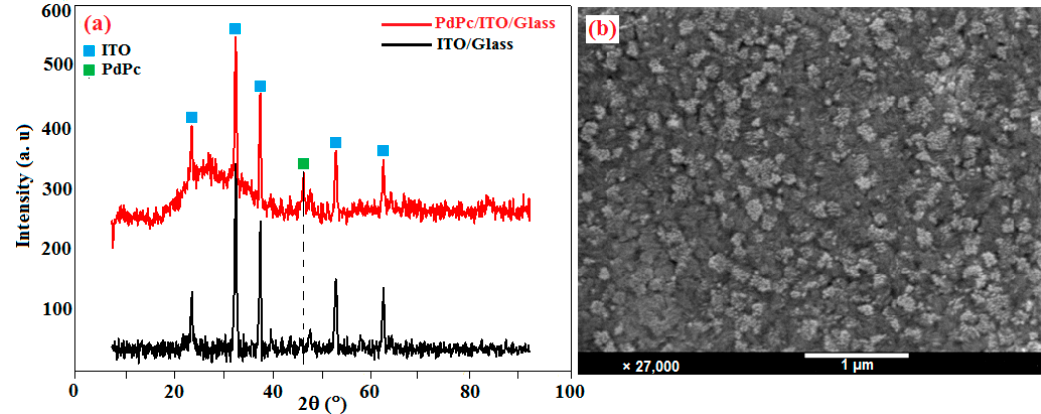
Figure 4. ( a ) XRD spectra and ( b ) SEM image of PdPc thin films grown by vacuum thermal evaporation technique on ITO / glass